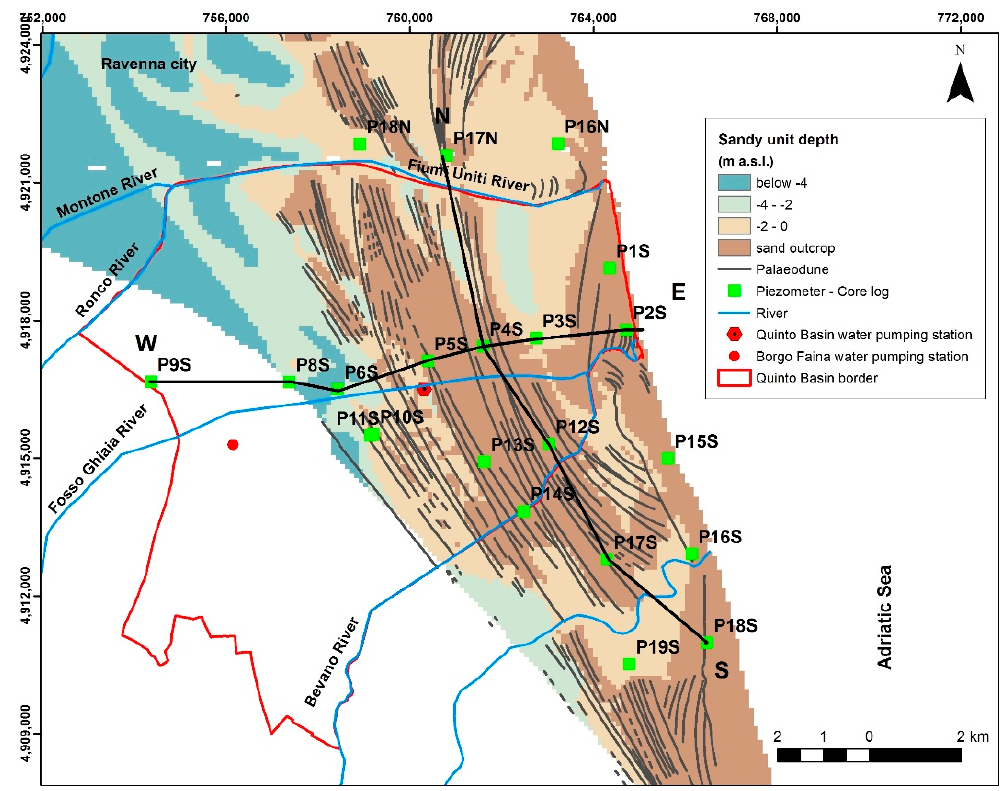
Figure 2. Sandy unit depths of the shallow coastal aquifer. Shown are also piezometers and cross section locations across the study area.